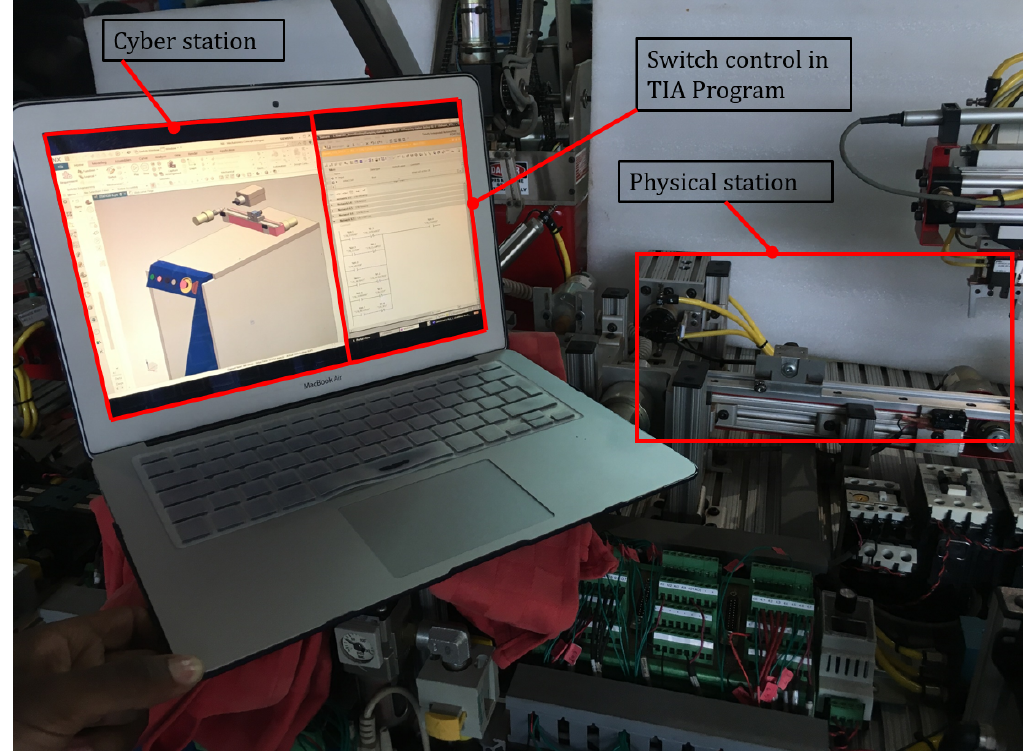
Figure 10. Integration of the cyber and physical